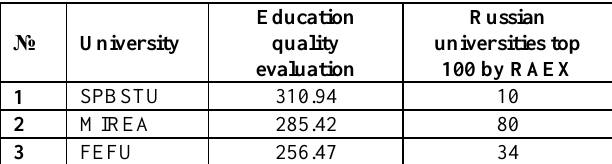
Table 7 – Education quality evaluation of Russian technical universities by free access data